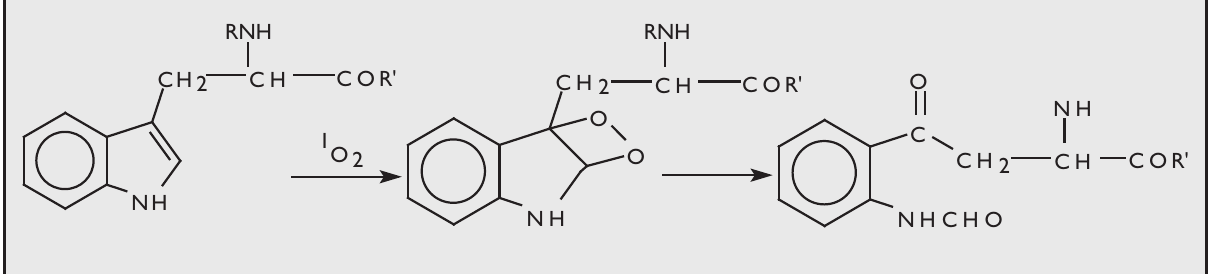
Figure 4 – Reaction of singlet oxygen with tryptophan